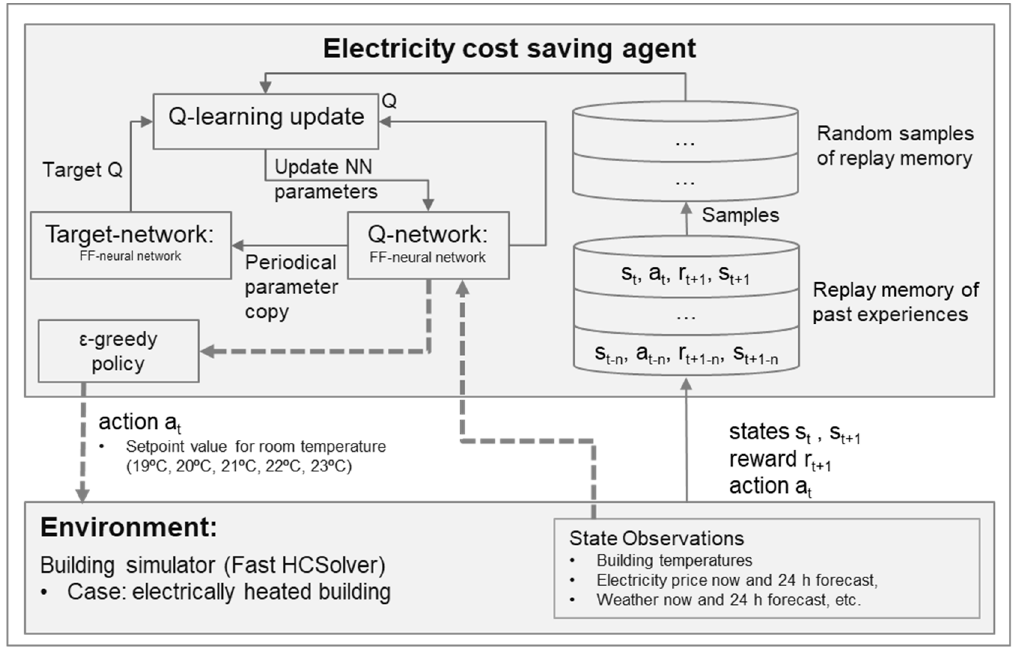
Figure 2. The implemented reinforcement learning case for finding the best next day electric heating setpoint values for achieving optimal reward (electricity bill savings).